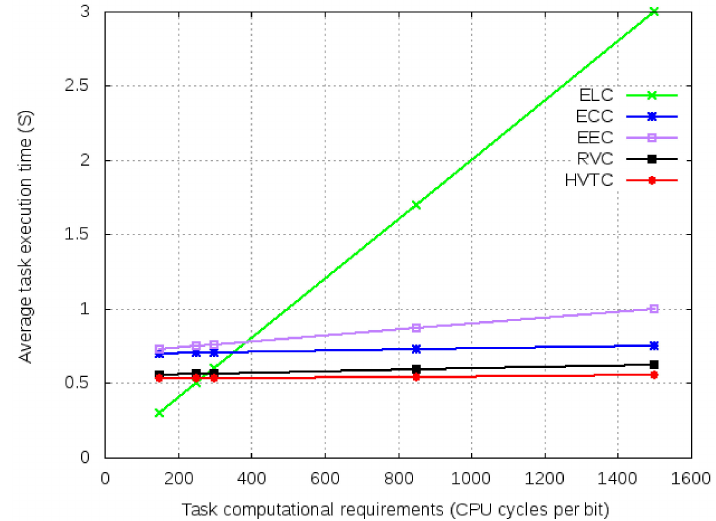
Figure 12. Average execution time for varied task computational